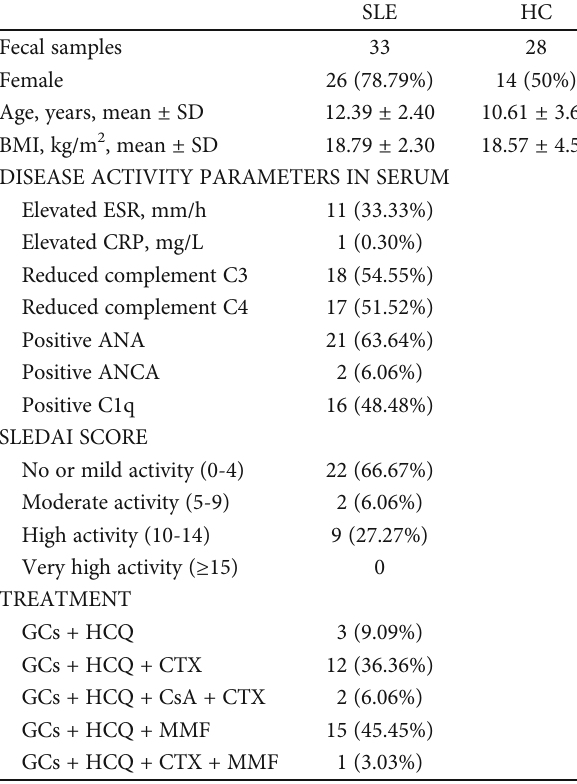
Table 1: Characteristics of the study cohorts.